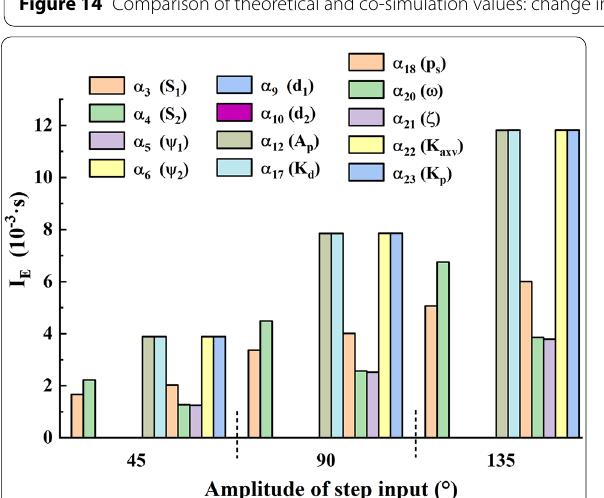
Figure 15 Histogram of sensitivity index under different step inputs and no-load condition